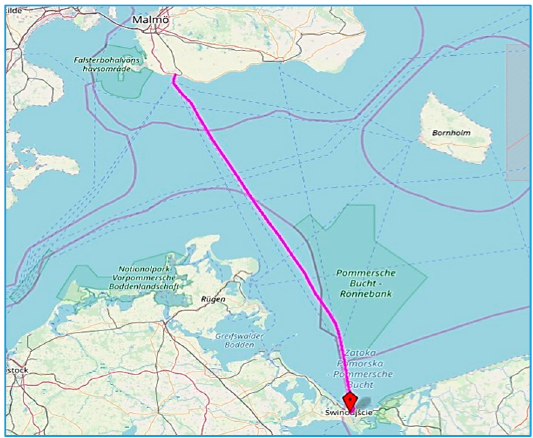
Figure 10. Ship single voyage trace.